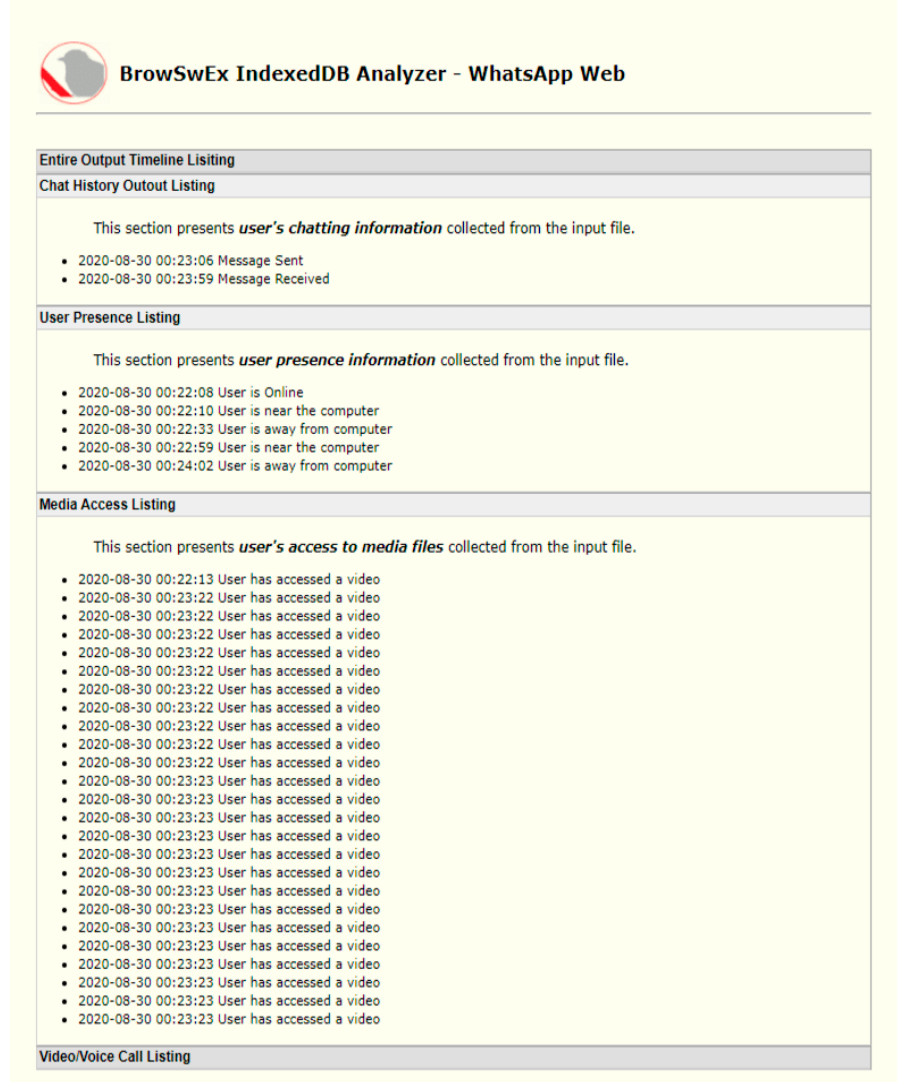
Figure 3. Future Internet 2020 , 12 , x FOR PEER REVIEW